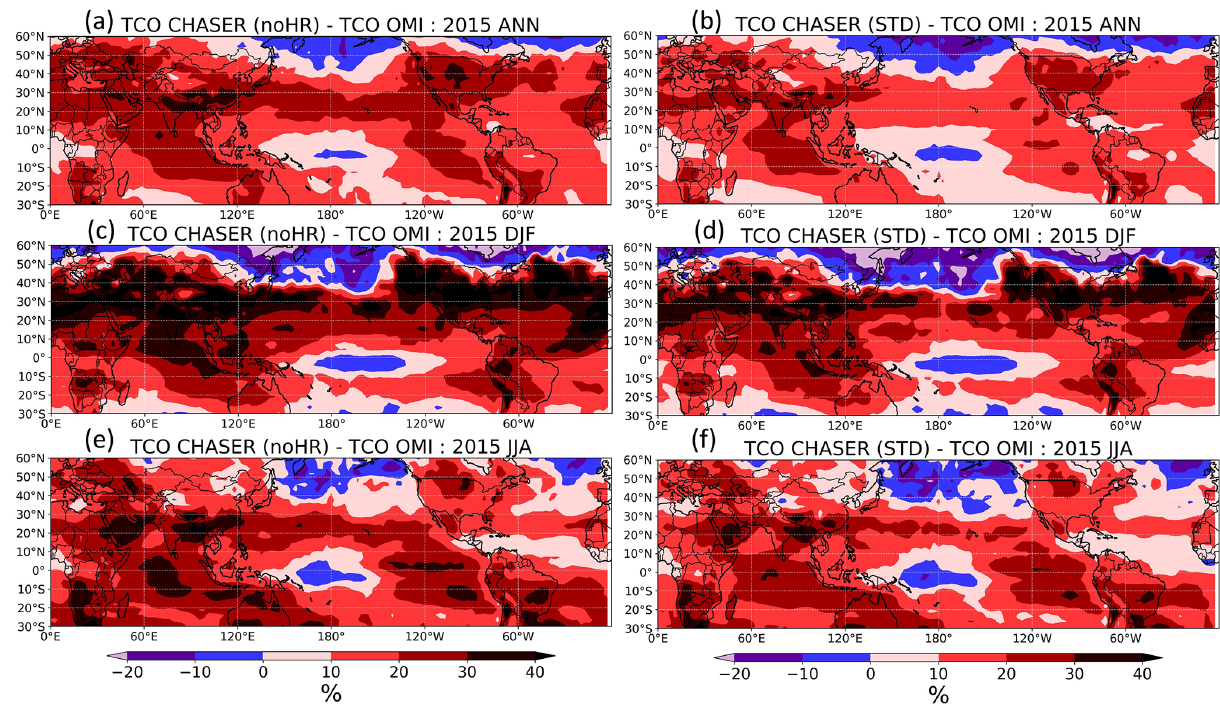
Figure 7. Differences in tropospheric column ozone (TCO) in CHASER’s noHR (a, c, e) and STD (b, d, f) runs from OMI: ANN is annual; DJF is December, January, February; and JJA is June, July, and